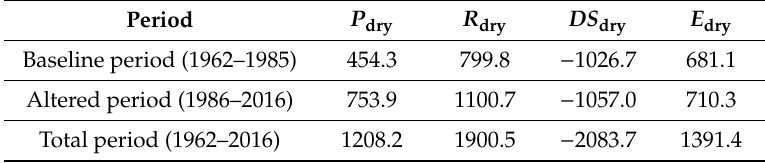
Table 6. Change in hydro-climatic variables (mm) in the dry season between the baseline and altered